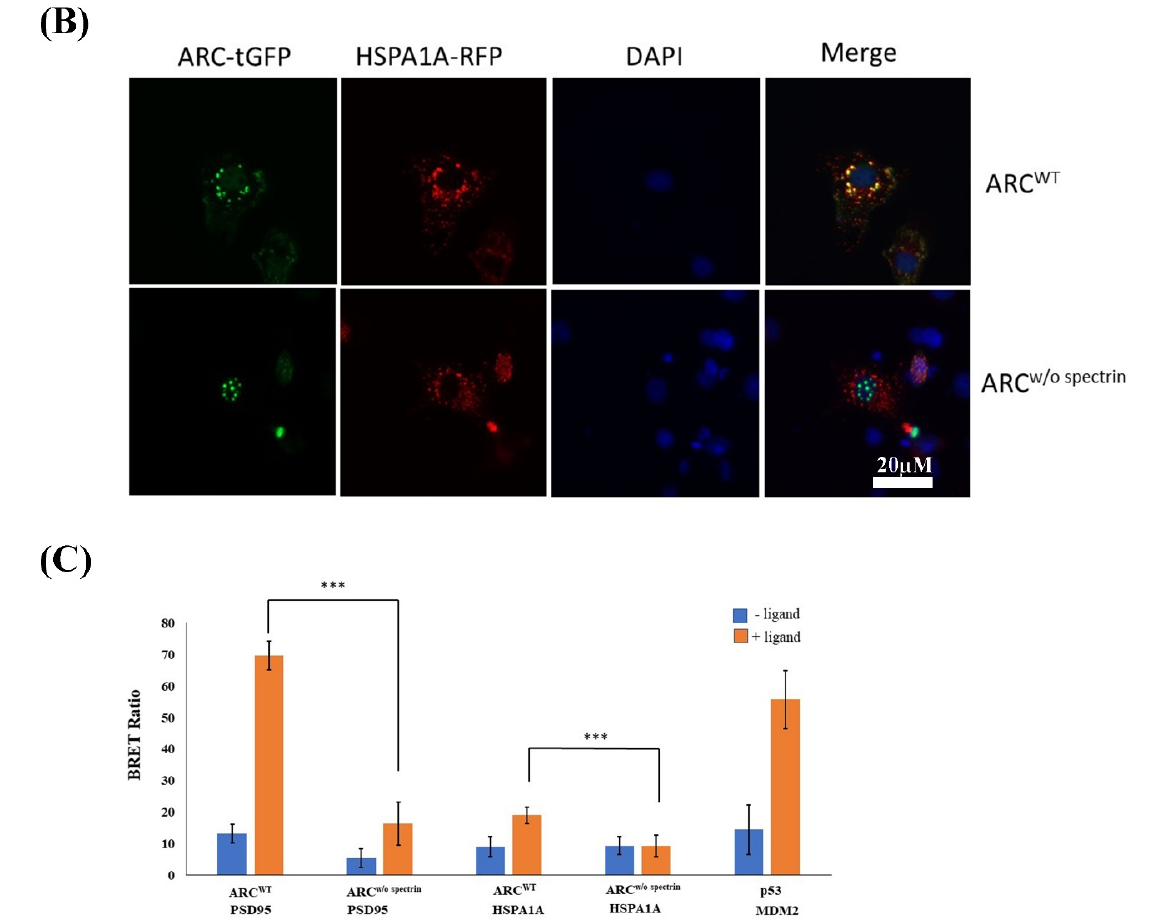
Figure 5. Protein–protein interaction analyses. ARC WT (green) colocalized with ( A ) PSD95 (red) and ( B ) HSPA1A (red) in transfected COS-1 cells. ( C ) BRET assay analysis of ARC interactions in HEK293 cells. BRET ratios are shown for ARC WT /PSD95, ARC w/o spectrin /PSD95, ARC WT /HSPA1A, and ARC w/o spectrin /HSPA1A combinations, as well as the MDM2/p53 positive control. Each experiment was performed six times with (+) and without ( − ) the addition of the NanoBRET™ 618 fluorescent ligand. Data are means ± SD (*** p < 0.0005). DAPI (blue), 4 ′ ,6 ‐ diamidino ‐ 2 ‐ phenylindole.